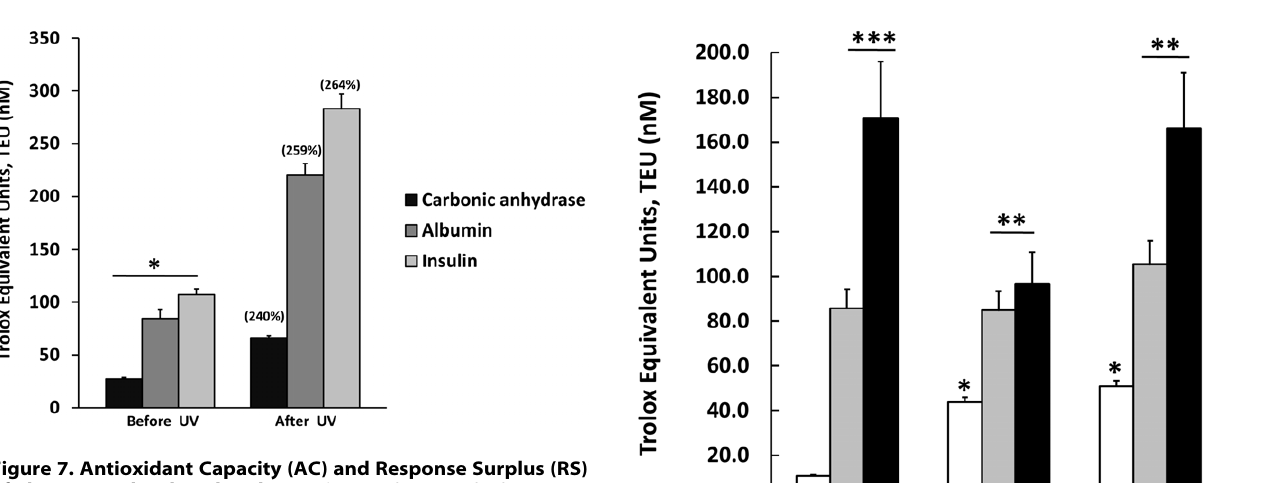
Figure 7. Antioxidant Capacity (AC) and Response Surplus (RS) of three not closely related proteins. Carbonic Anhydrase (CA), Bovine Serum Albumin (BSA) and Insulin (I) presented different AC and relatively similar RS after being exposed to UV light as structural stressor. The AC of the proteins was measured before and after exposure to UV light for 1.5 minutes. Antioxidant capacity changed on average from 27, 84, and 107 nM TEU to 66, 220 and 283 nM TEU (CA, BSA and I respectively). The percentages in parentheses above the bars correspond to each ACA% value. Results are expressed as mean 6 SD (n=5). P , 0.01 when compared before and after UV light exposure.